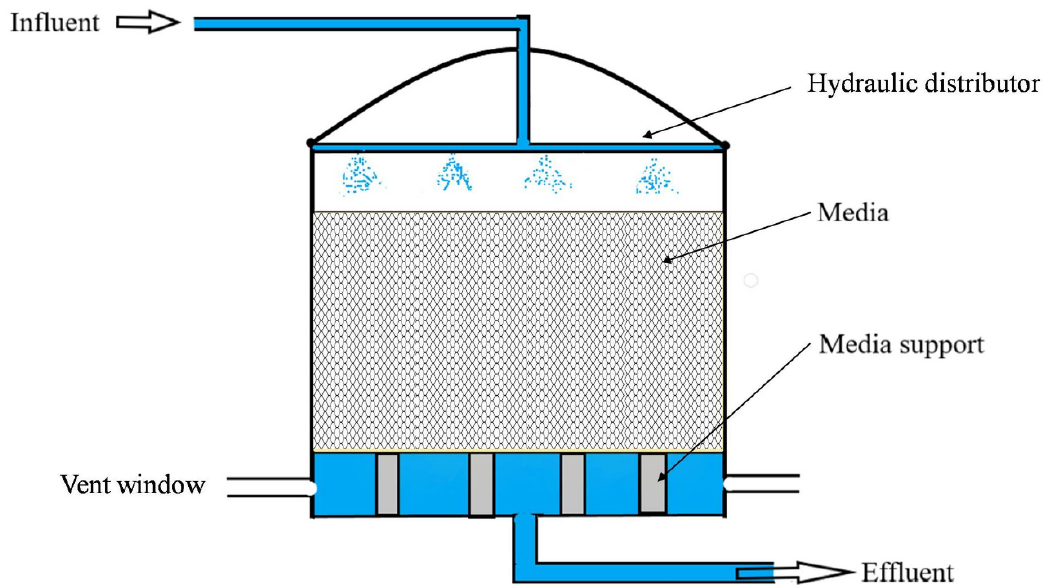
Figure 3. Major components of a trickling filter.